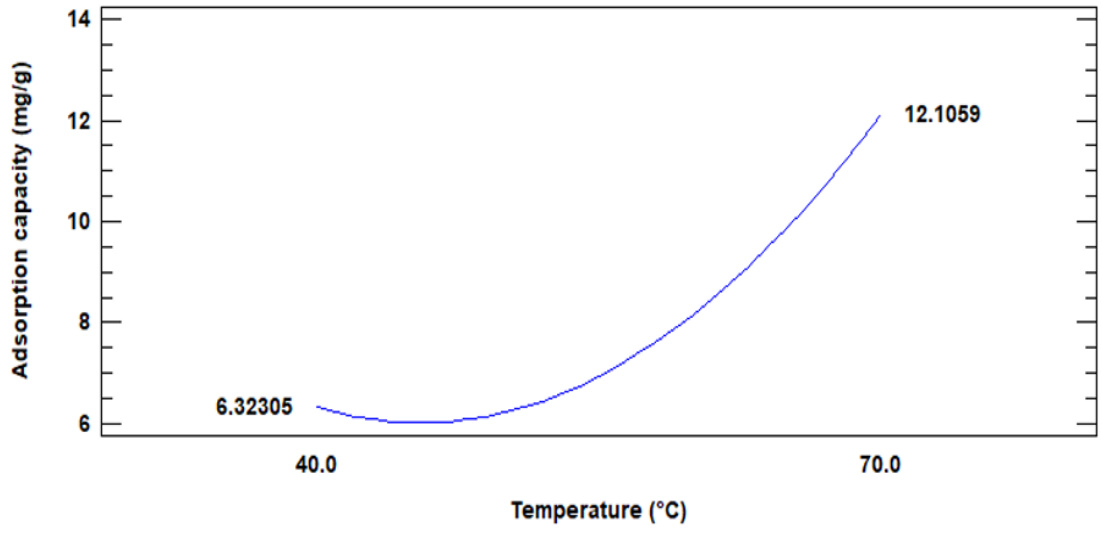
Figure 3. Main effect plot of temperature on the adsorption capacity of Cr (VI).